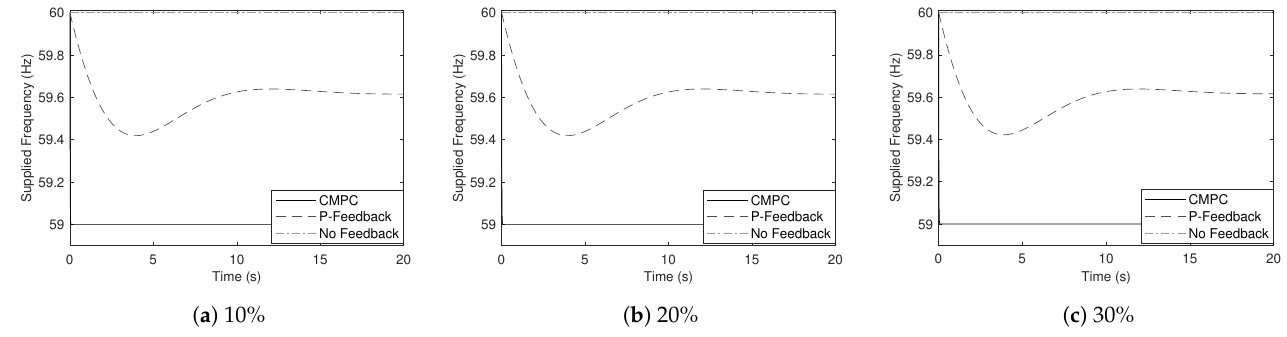
Figure 10. SST supplied frequency under a 2GW power loss.